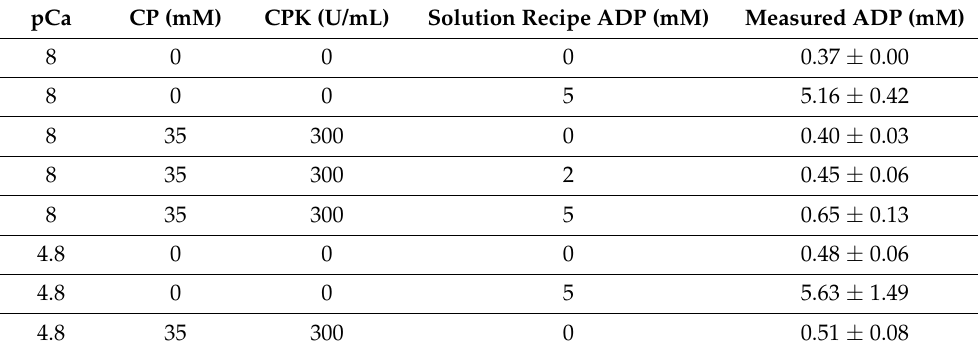
Table 1. Solution recipe conditions vs. measured